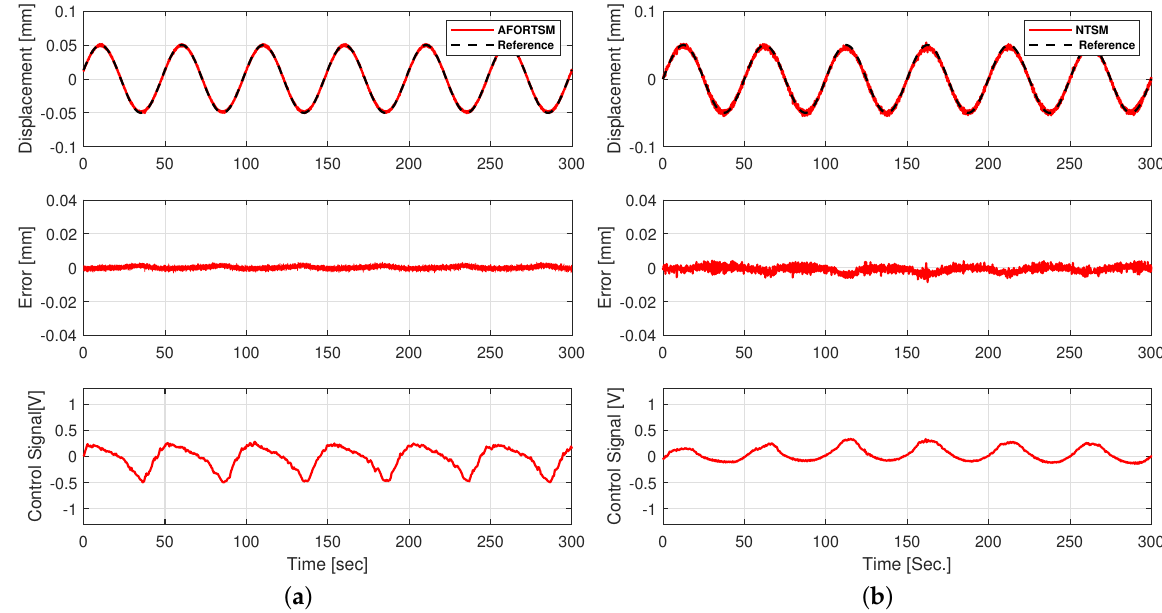
Figure 2. Test 1: Experimental results of AFORTSM and NTSM for tracking a single-tone sinusoidal reference without uncertainties (top: tracking profiles; middle: tracking error; bottom: control signal). ( a ) AFORTSM; ( b )